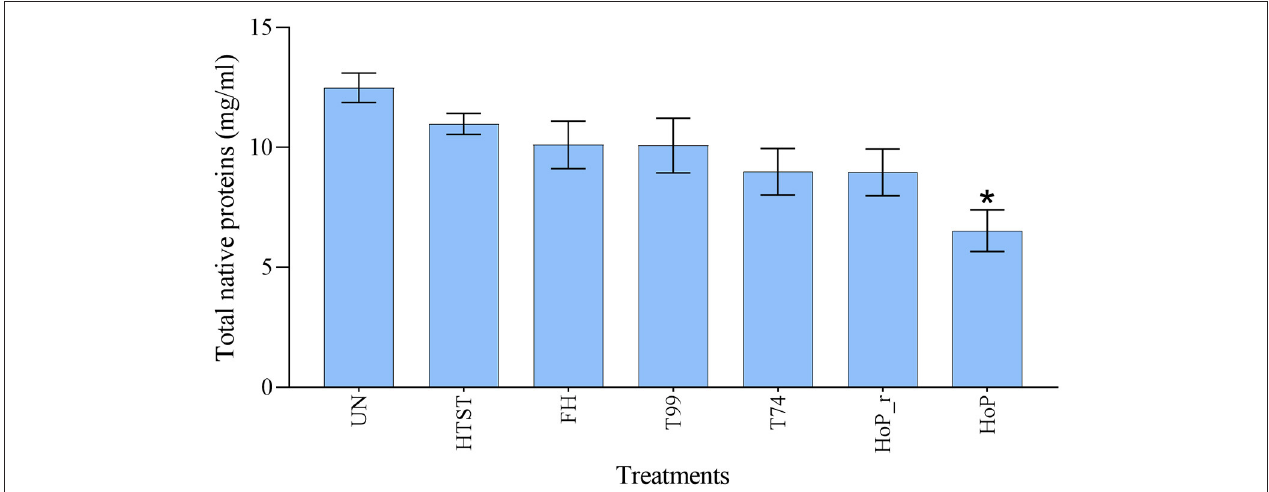
FIGURE 3 | Total native milk serum protein concentration (mg/ml) of untreated and the differently heat-treated DHM samples. The analyses were performed in duplicate for each sample and all values are presented as mean ± standard deviation of two independent experiments. *Expresses statistically significant difference to untreated samples ( p < 0.05). UN, HTST, FH, T99, T74, HoP and HoP_r stand for untreated DHM, and DHM treated with high-temperature short-time, flash heating, high-temperature short-time with a thermomixer preheated at 99 ◦ C, high-temperature short-time with a thermomixer preheated at 74 ◦ C, holder pasteurization and holder pasteurization with rapid heating up-times,